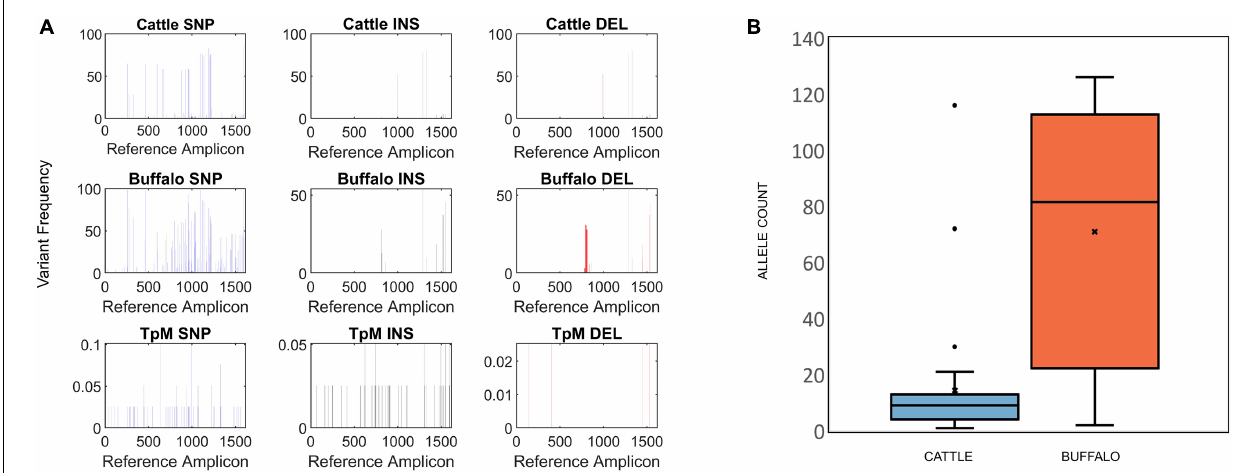
FIGURE 2 | (A) Single Nucleotide Polymorphism (SNP), insertion (INS) and deletion (DEL) frequency for amplicon data across the length of the Tp1 amplicon, with respect to the TpM reference sequence. The mean calculated SNP/INDEL frequency is shown at each base location for the Tp1 gene. Blue bars represent SNPs, black bars represent insertions and red bars represent deletions. (B) Tp1 allele counts in cattle- (blue) and buffalo-derived (orange) samples. Median (line), mean (x) and standard deviation (whiskers) are shown, dots represent outlier samples with extreme allele